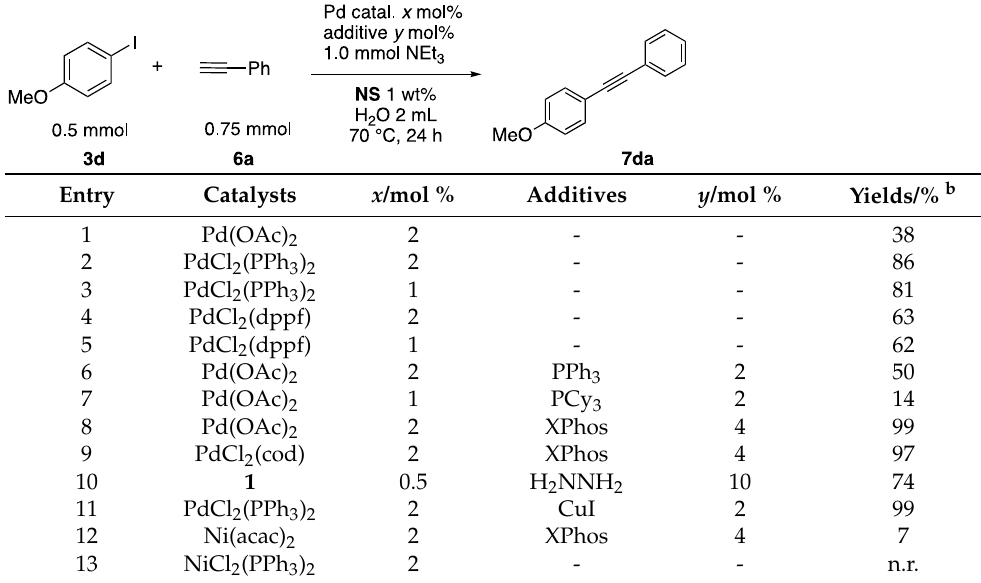
Table 5. Copper-free Sonogashira coupling in water with Pd catalysts a .